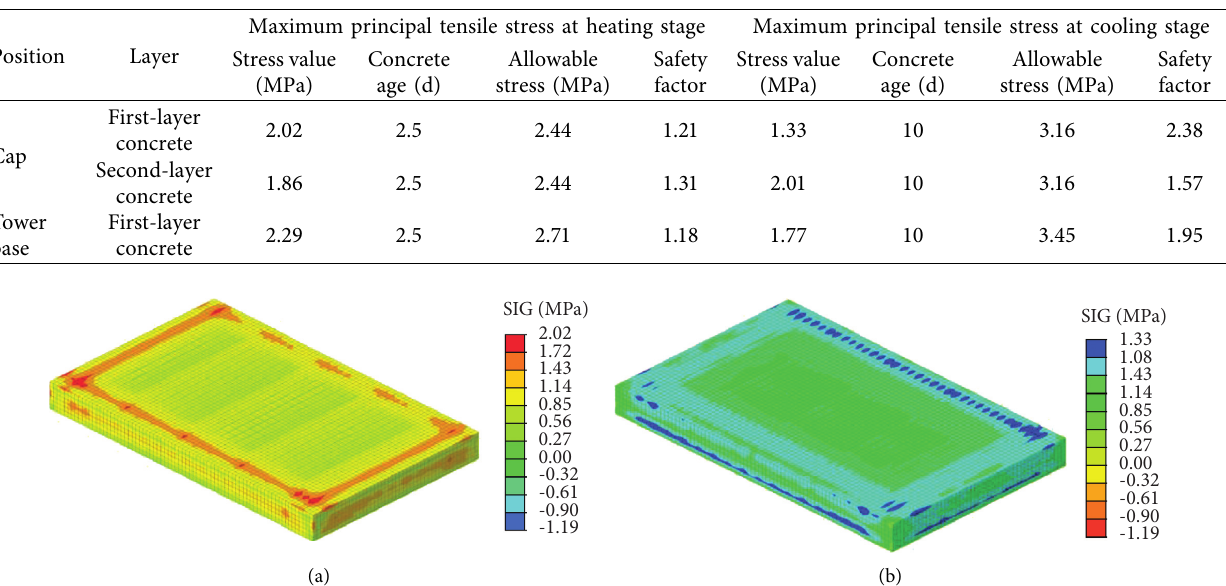
Figure 11: Concrete temperature time-history curve of tower. Table 4: Stress calculation results.